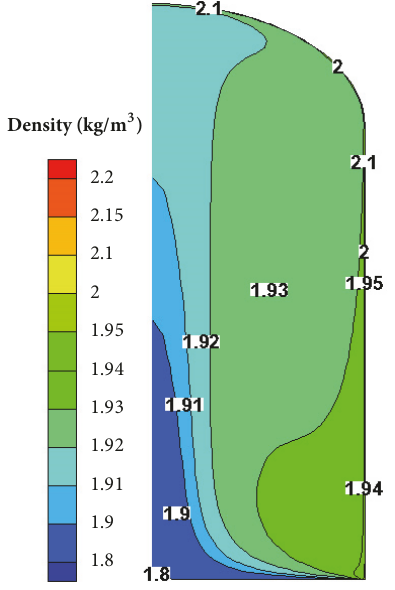
of condensation wall is set as 373.15 K, and the steam mole fraction of total gas mixture is 50%, which is the same as previously done. Cases with different percentage of hydrogen are simulated. The percentage of hydrogen in the noncon- densable gases changes from 0% to 100%. With the increase of the hydrogen mole fraction, the steam diffusion coefficient will increase, as shown in Figure 18. Figure 19 shows the maximum concentration (or species) gradient and maximum gas mixture velocity in the containment will decrease with increasing hydrogen concentration. The effect of